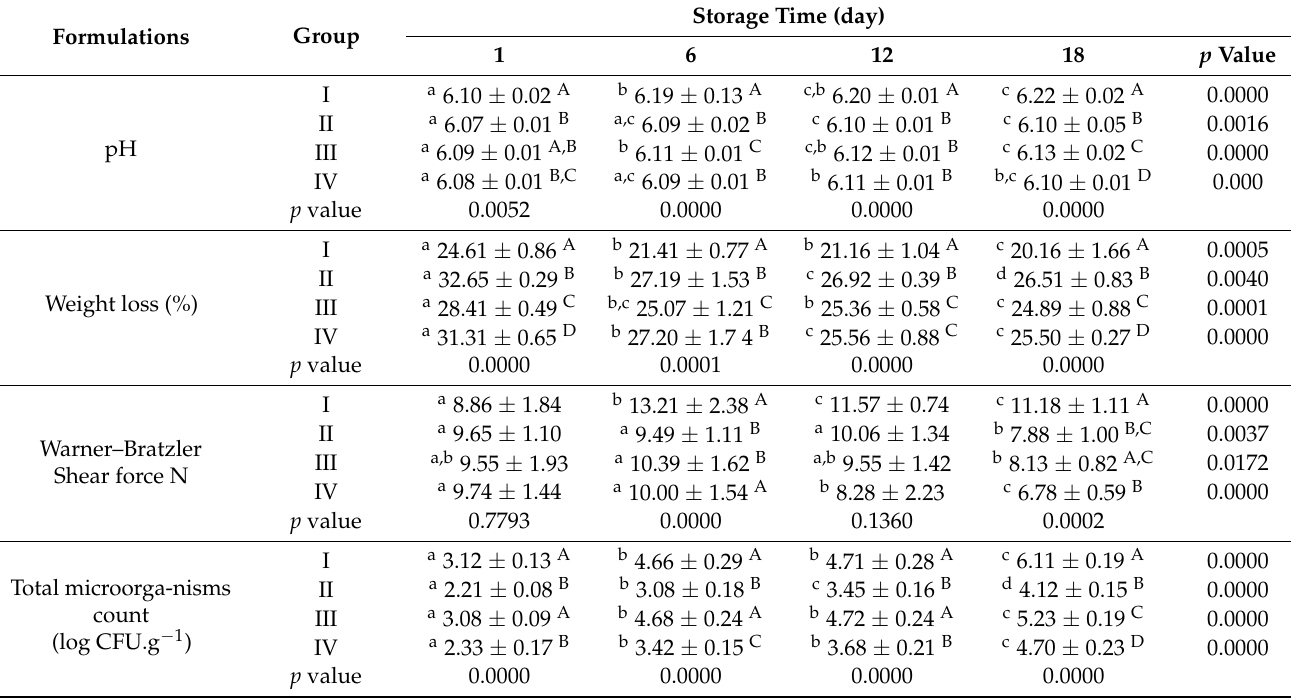
Table 2. Effect of turmeric addition and storage time on pH, weight loss, shear force, and total number of microorganisms in duck burgers during